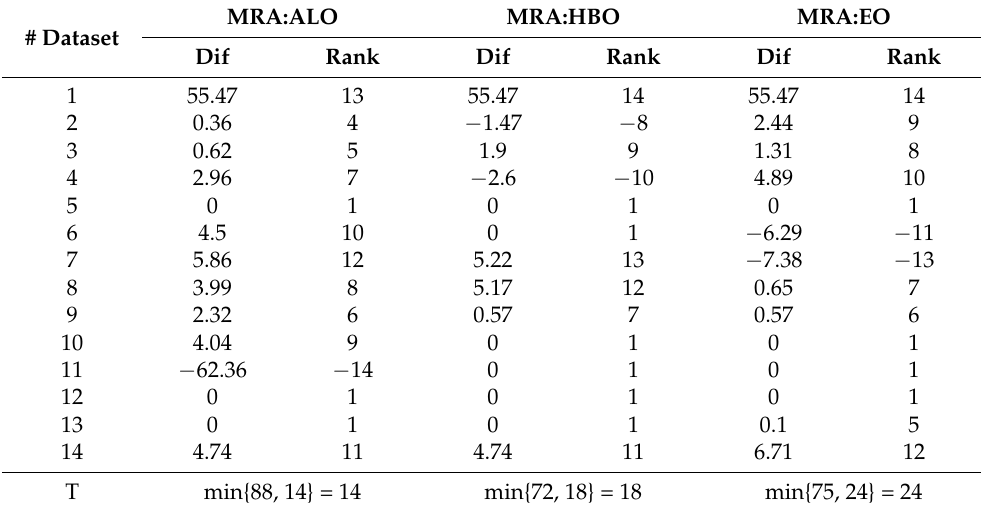
Table 6. Wilcoxon signed-rank for test